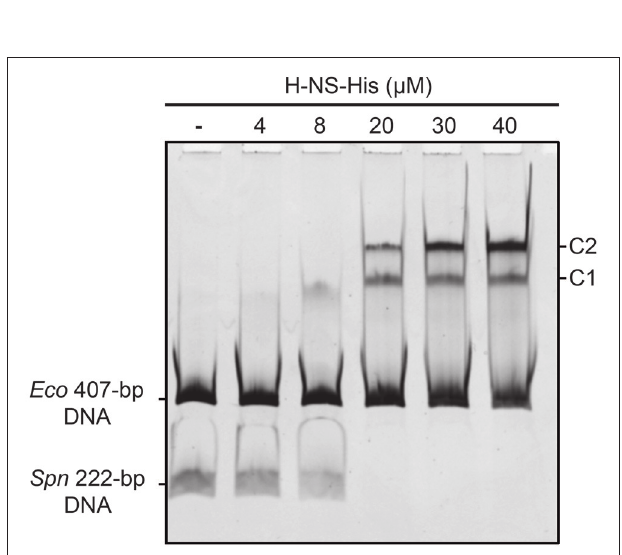
FIGURE 6 | Binding of H-NS-His to the pneumococcal 222-bp DNA fragment (competitive EMSA). The pneumococcal 222-bp DNA fragment (50 ng) was incubated with increasing concentrations of H-NS-His in the presence of competitor DNA (407-bp DNA fragment from the E. coli plasmid pHly152; 150 ng). Free and bound DNAs were separated by native gel electrophoresis (5% polyacrylamide). Bands corresponding to free DNAs and protein-DNA complexes (C1 and C2) are